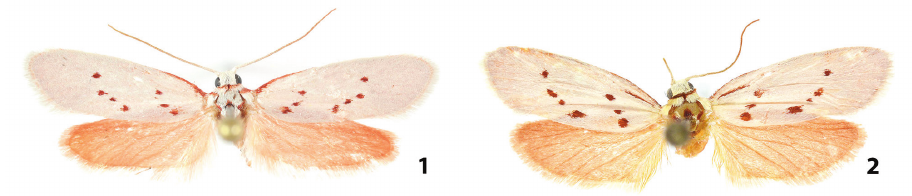
Figures 1, 2. Adults of Lactura rubritegula and L. basistriga . 1 HOLOTYPE male Lactura rubritegula . TX: